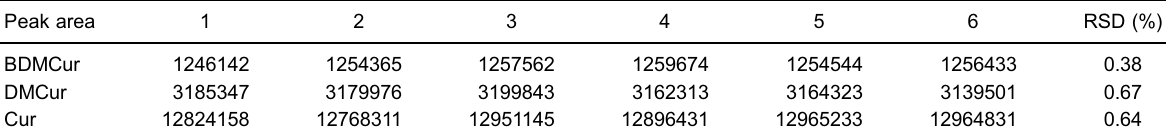
Table 1. Results of the precision test of bisdemethoxycurcumin (BDMCur), demethoxycurcumin (DMCur) and curcumin (Cur). Peak